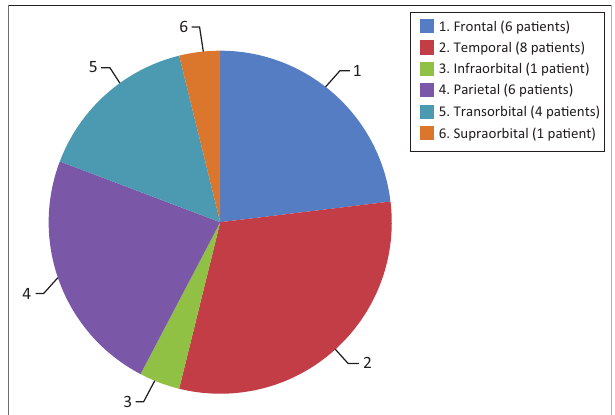
FIGURE 2: Number of patients and region of stab wounds.